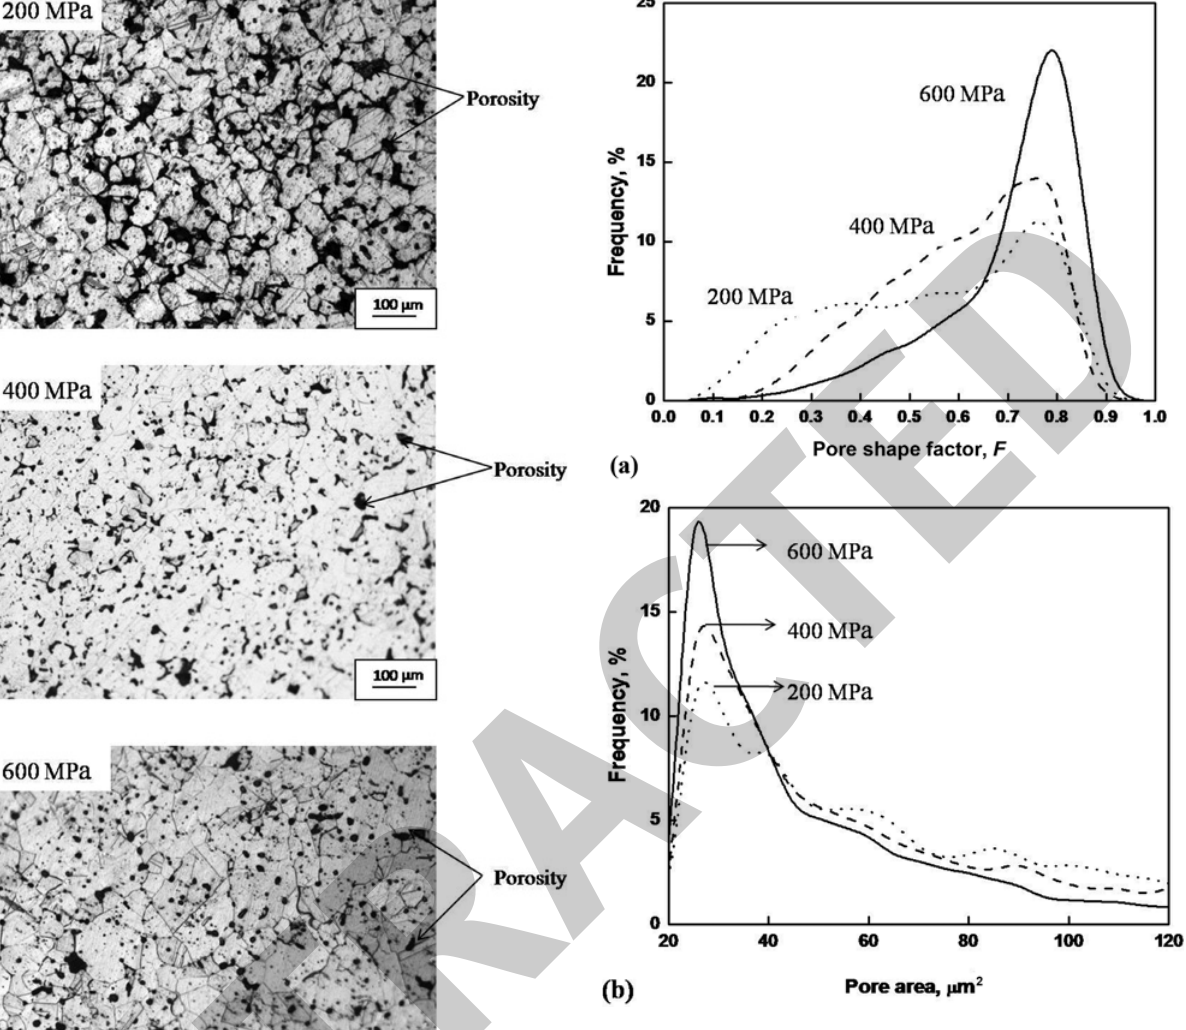
Figure 3: Comparison of (a) pore shape factor distribution and (b) pore area distribution of 316L samples compacted at different pressures (200, 400 and 600 MPa) and sintered at